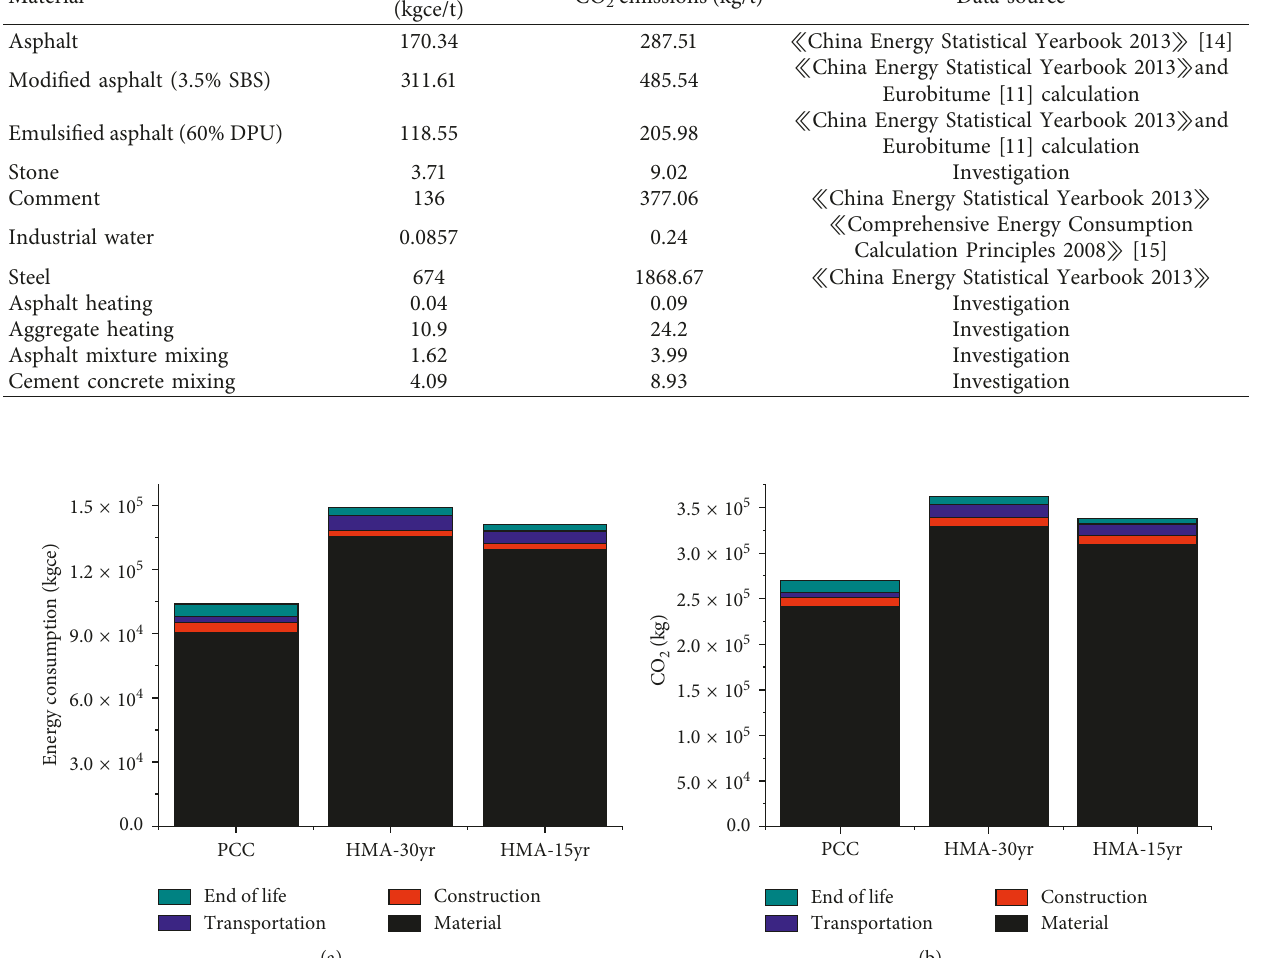
2 emission of the three pavement structures.